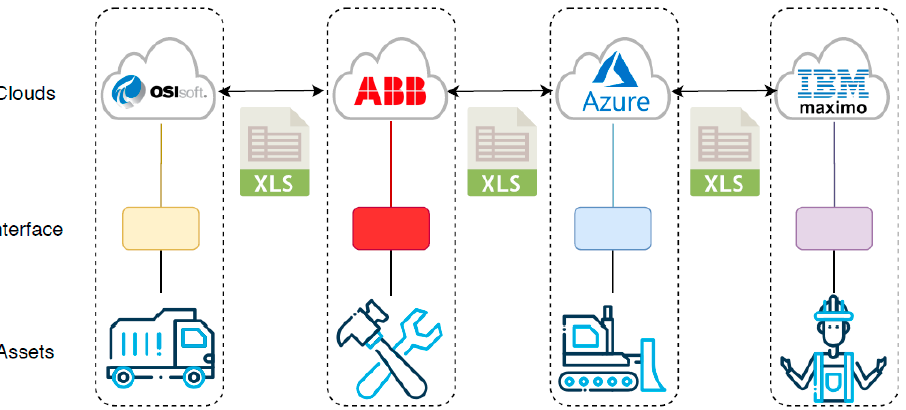
Figure 4. Vertical and horizontal interactions between domains of Mining 4.0 (Reprinted from Ref. [30]).